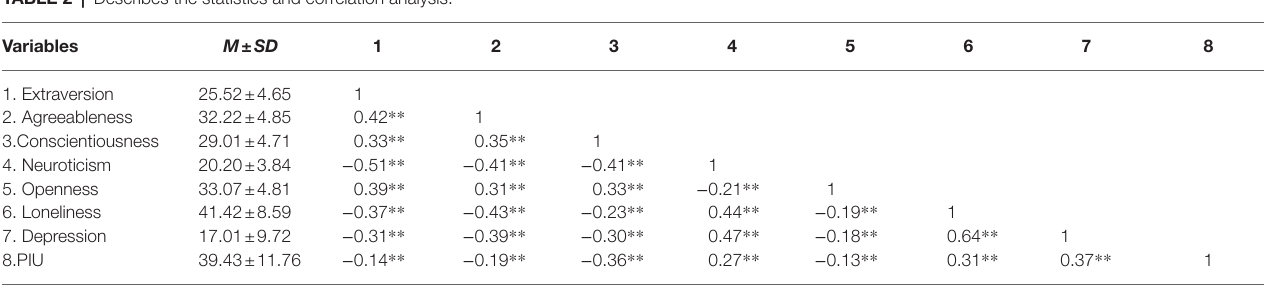
TABLE 2 | Describes the statistics and correlation